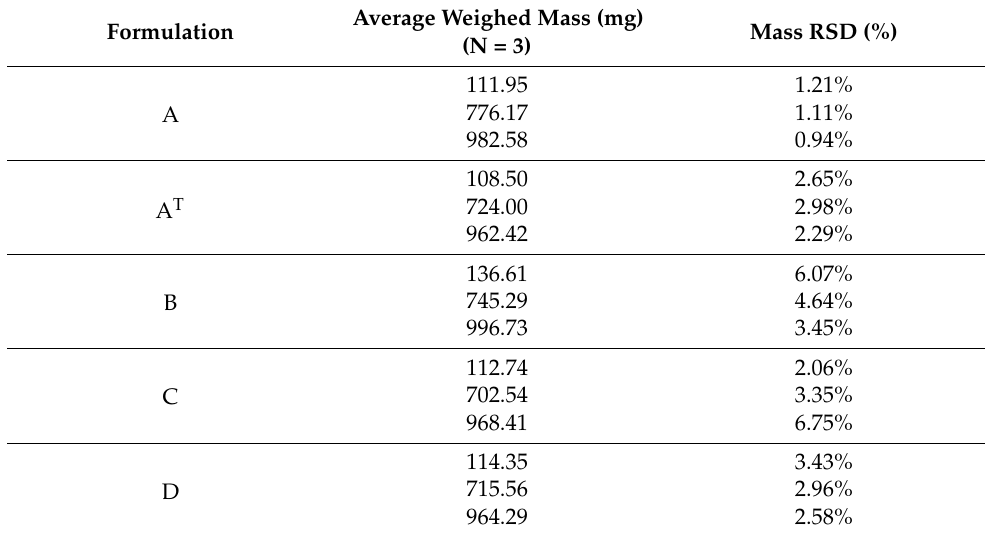
Table 8. Summary of oral forms masses printed from formulation A, A T , B, C and